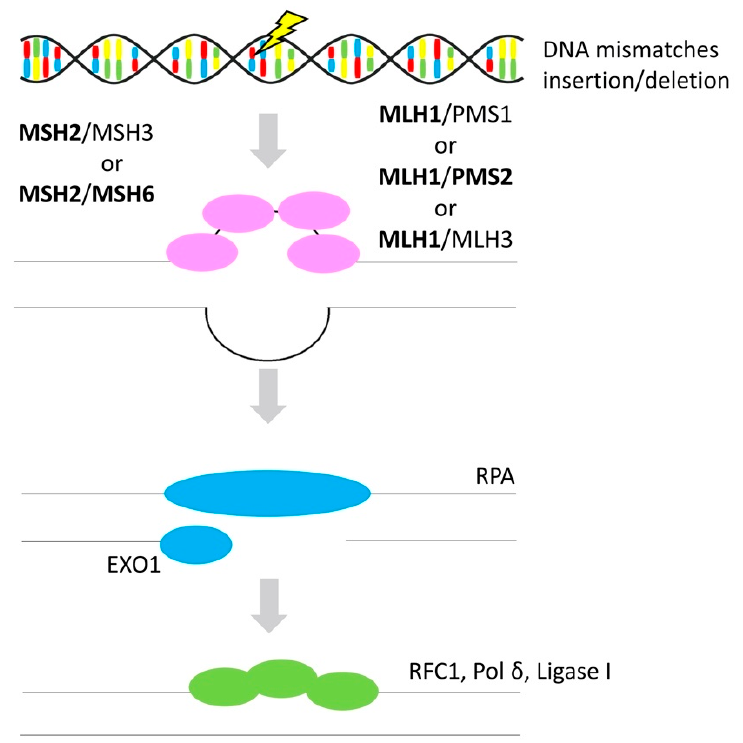
Figure 4. Mismatch repair. Simplified scheme of mismatch repair of DNA mismatches or insertion/ deletions mispairs (gene alternations in OvC in bold ) [111]. Protein names: MutS homolog 2 (MSH2), MutS homolog 3 (MSH3), MutS homolog 6 (MSH6), MutL homolog 1 (MLH1), PMS1 homolog 1 (PMS1), PMS1 homolog 2 (PMS2), MutL homolog 3 (MLH3), replication protein A (RPA), exonuclease 1 (EXO1),